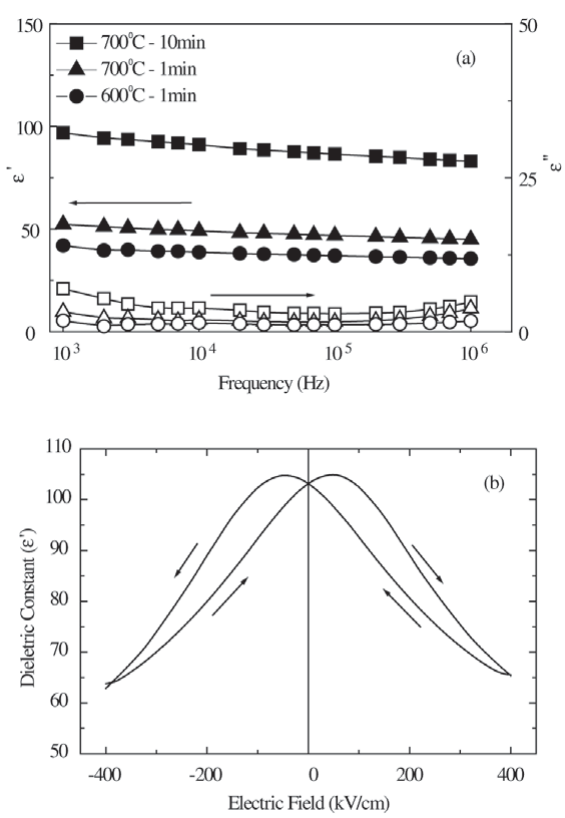
Figure 4. a) Frequency dependency of the real ( ε ’) and imaginary ( ε ’’) part of the electrical permittivity for the films annealed at differ- ent conditions; b) dielectric constant dependence on the electric